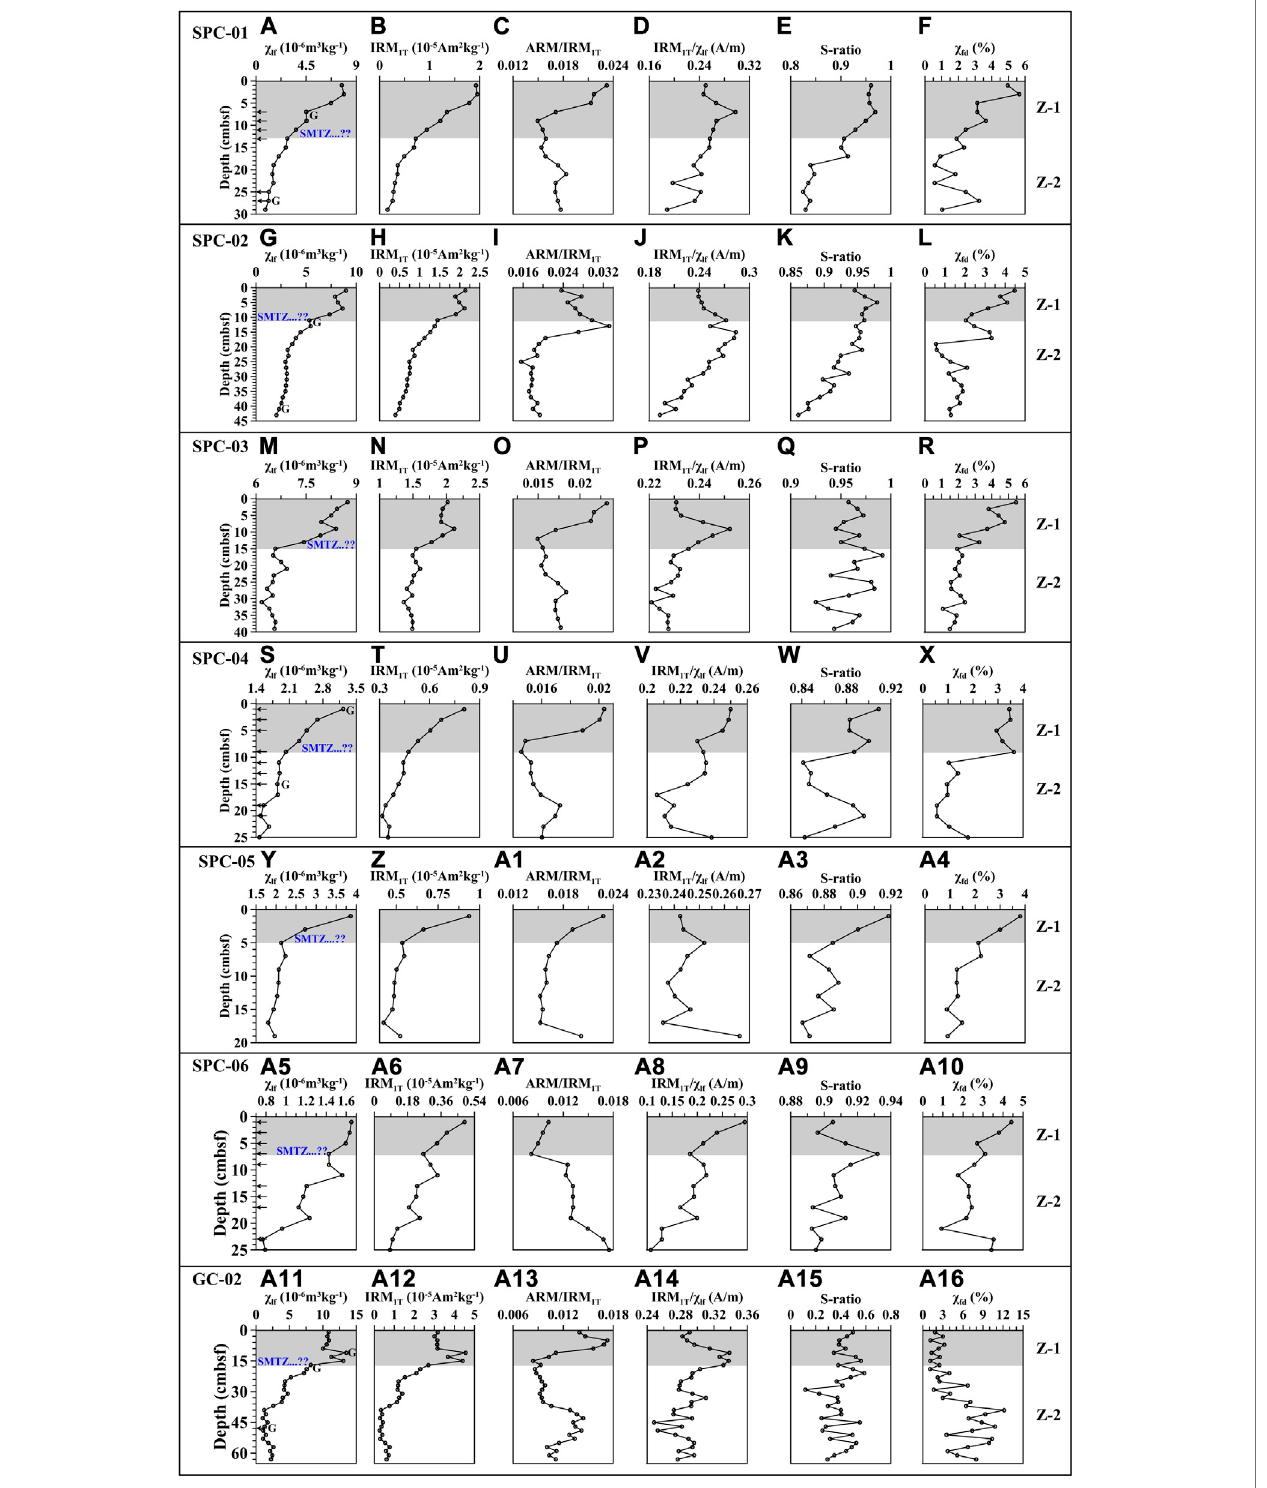
FIGURE 2 | Down-core variations of selected rock magnetic data of spade (A – E) : SPC-01, (F – J) : SPC-02, (K – O) : SPC-03, (P – T) : SPC-04, (U – Y) : SPC-05, (Z – A4) :SPC-06,andgravitysedimentcores (A5 – A9) :GC-02.BasedonmagneticsusceptibilityvariationstwosedimentarymagneticzonesZ-IandZ-IIaredemarcated. Z-I highlighted with gray shading. (Please note that χ lf, low frequency magnetic susceptibility; ARM, anhysteretic remanent magnetization; and IRM 1T , isothermal remanent magnetization; χ fd %, frequency dependent susceptibility). Depth of carbonate occurrence are highlighted in solid black arrows (horizontal). The depth of greigite occurrence is marked by “ G. ” Sediment magnetic zones (Z-I, Z-II) in each pro fi le are marked.